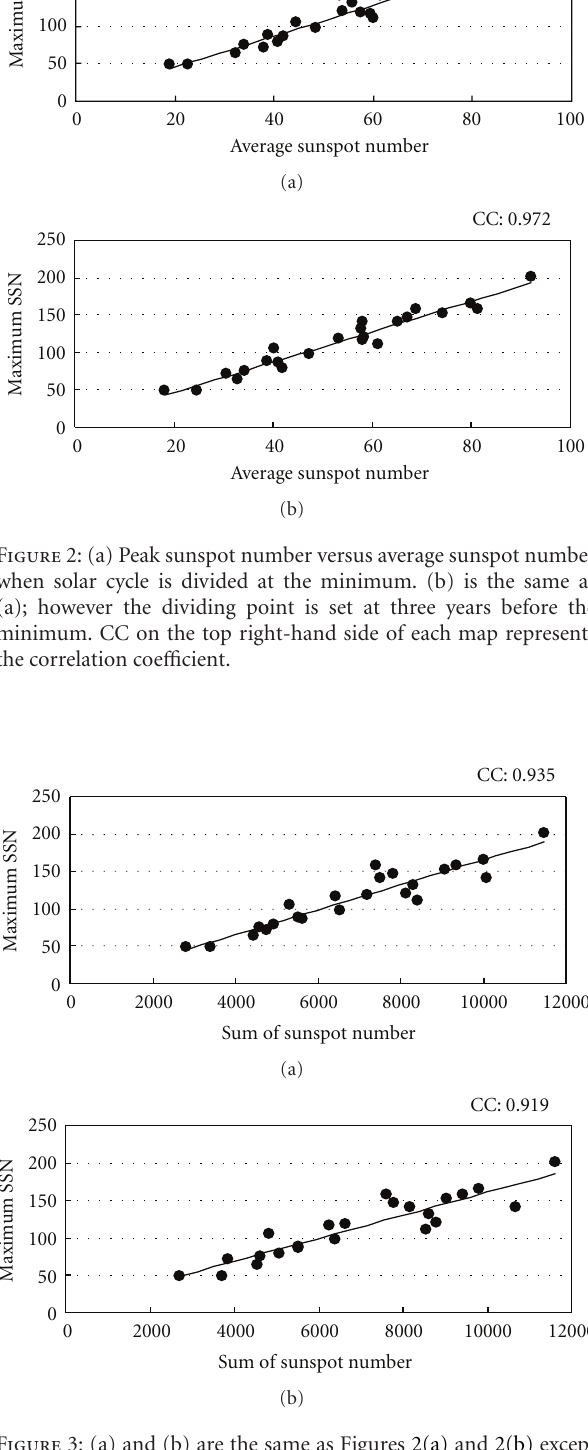
Figure 3: (a) and (b) are the same as Figures 2(a) and 2(b) except that sum of sunspot number over a cycle is taken instead of the average sunspot